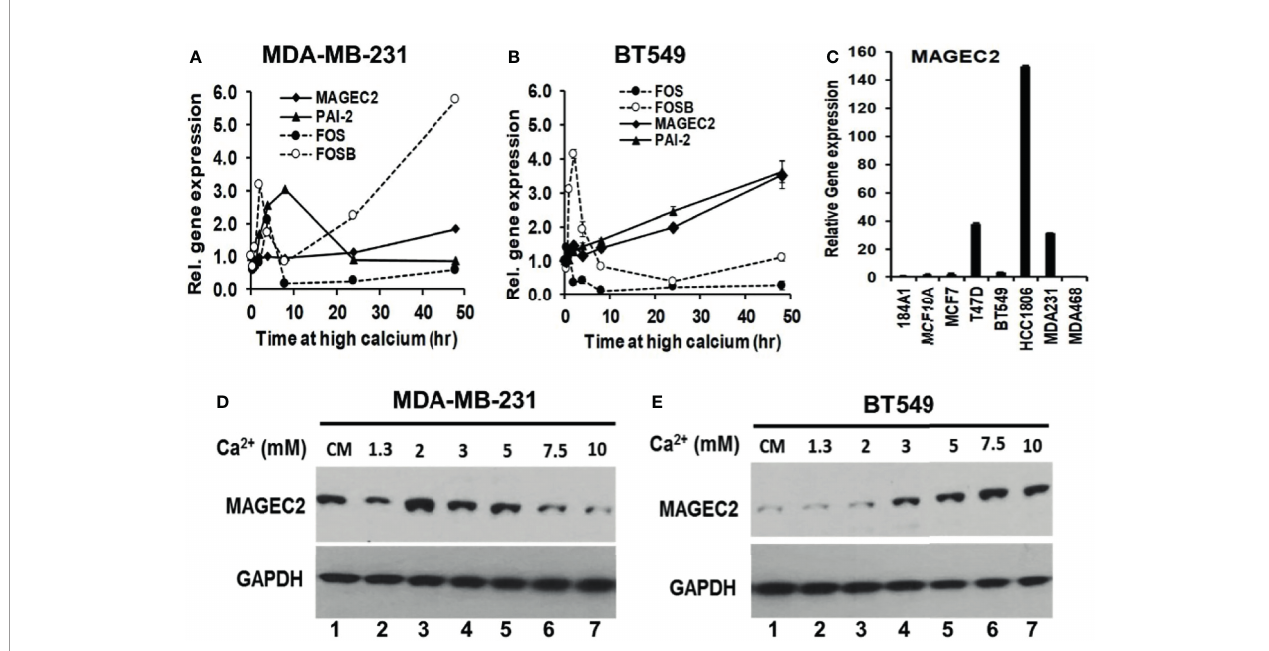
FIGURE 4 | Induction of MAGEC2 expression by high extracellular calcium in TNBC cells. (A, B) Cells were cultured in complete medium with or without high Ca 2+ (5.0 mM) for up to 48 h. Cells were harvested and total RNA extracted, and used for RT-PCR. Each point represents the expression of the indicated genes relative to GAPDH for MDA-MB-231 (A) and BT-549 (B) TNBC cells. (C) Total RNA was isolated from the indicated cell lines cultured in their respective complete media and the basal levels of MAGEC2 assessed by RT-PCR. (D, E) MDA-MB-231 (D) and BT-549 (E) TNBC cells were cultured in complete medium supplemented with the indicated concentrations of Ca 2+ , for 48 h. Cells were harvested and the expression of MAGEC2 protein was analyzed by western